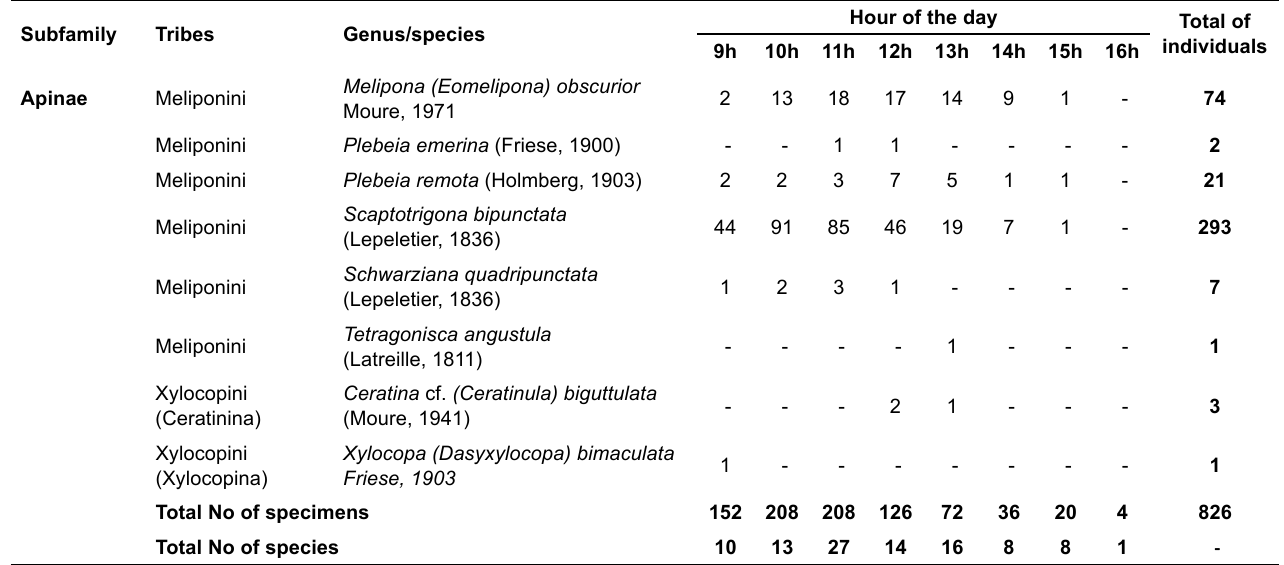
Table 2. Dial pattern of the number of flower visiting bees captured on Eugenia uniflora L., in fragments of mixed ombrophilous forest.